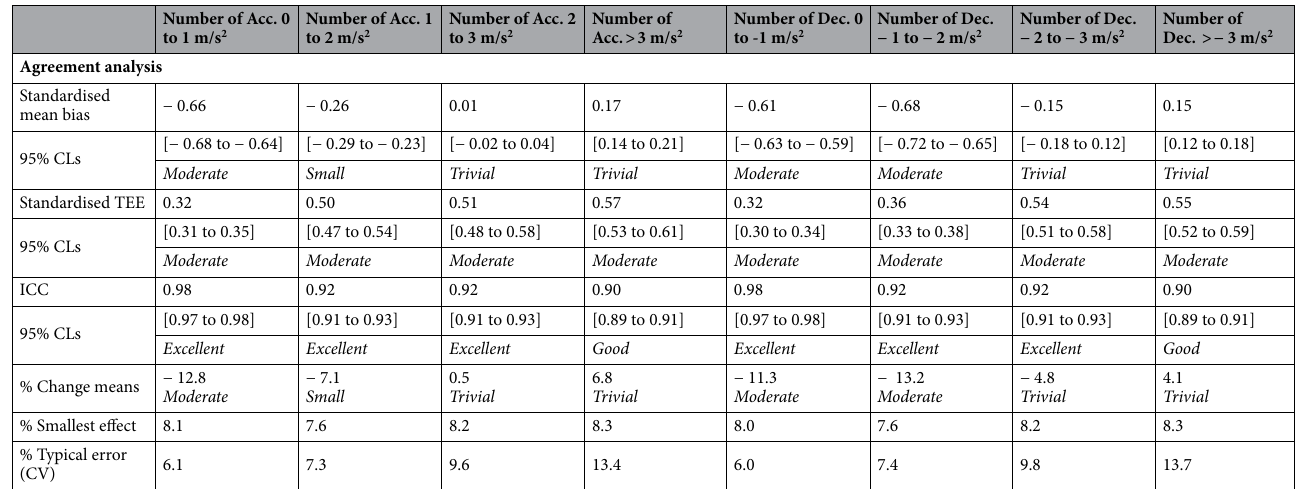
Table 3. Comparison of each variable in the number of acceleration/deceleration in different sections analyzed by Mediacoach and Wimu data, including standardized mean bias, typical error of estimate (TEE), intraclass correlation coefficient (ICC), % change mean, % smallest effect and % coefficient of variation (CV), of all with 95% confidence limits. Acc . acceleration, Dec . deceleration, CLs confidence limits.